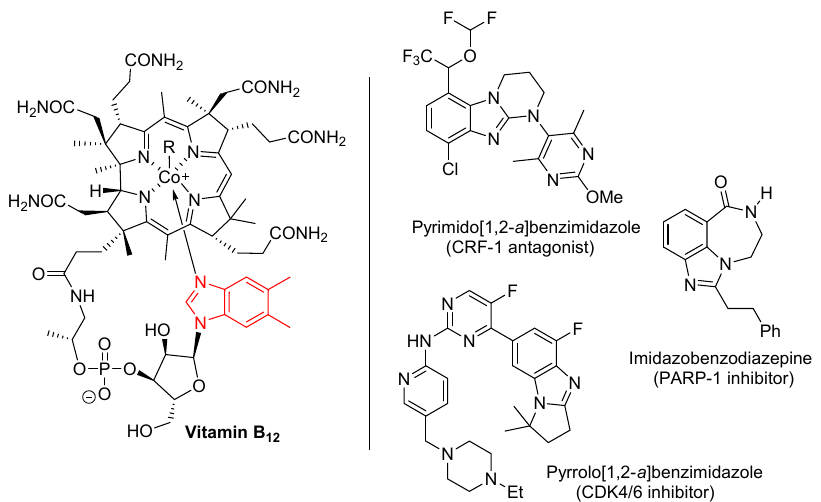
Figure 1. Benzimidazole in vitamin B 12 and biologically-active ring-fused systems [1–9].